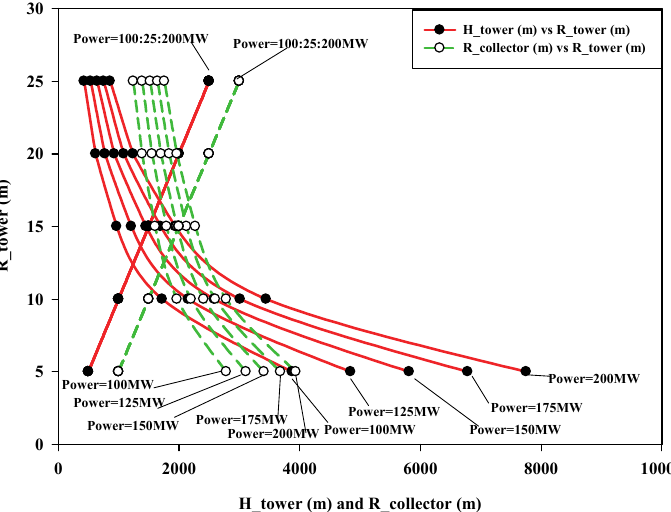
Figure 13. Effect of variation in tower height ( H Tower ) and collector radius ( R Collector ) on tower radius ( R Tower ) for fixed power output of SUTPP.